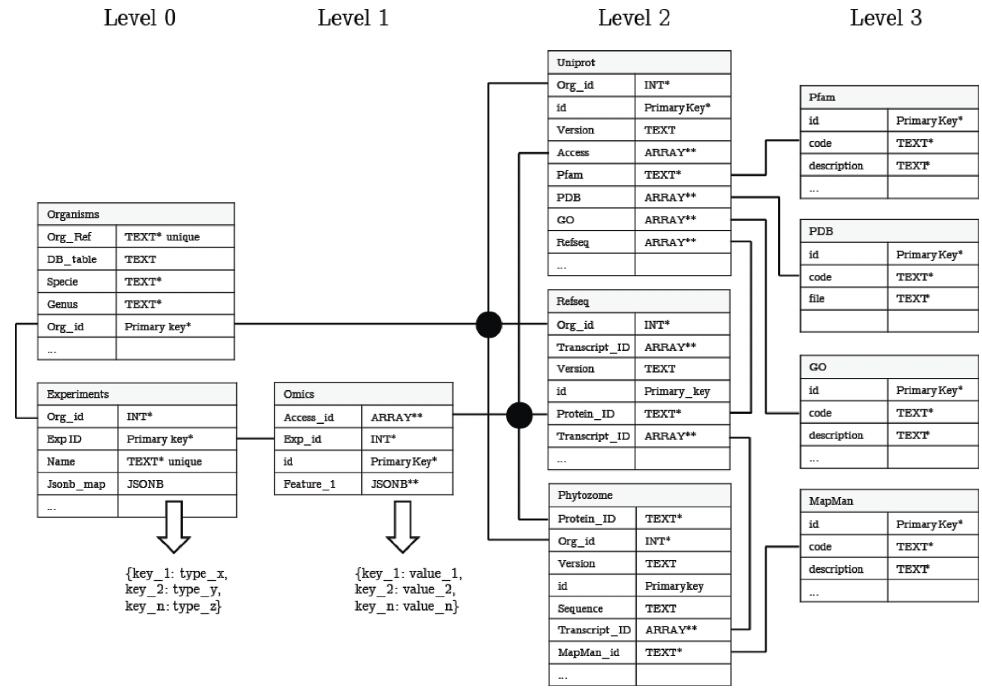
Figure 2: Design of the MinOmics ORBDMS. Collections of biological datasets are stored in the Organisms and Experi- ments tables (level 0). Table key relations unleash the efficiency of querying (black lines). The Omics table (level 1) stores the heterogeneous biological data obtained by high throughput technologies (RNASeq, Proteomic). Level 2 tables are the main public biological repositories stored on MinOmics (Uniprot, Refseq, Phytozome). Secondary databases (PDB, GO, Pfam, MapMan) are the level 3 tables. The nature and heterogeneity of biological datasets (data types) require an adapted indexing strategy (*btree indexing, **GIN